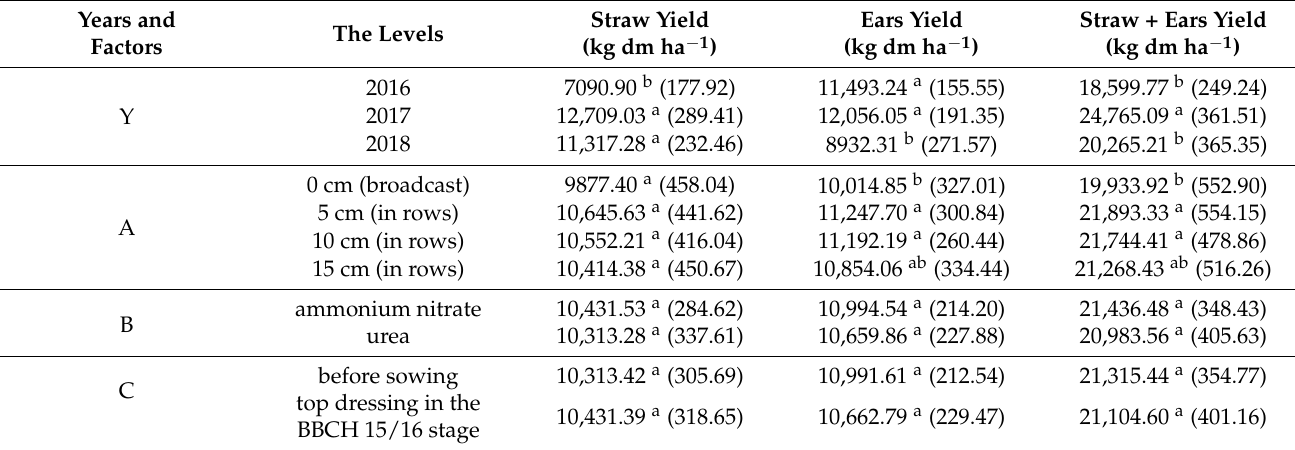
Table 6. Mean values of the traits for the years (Y) and NP fertilizer sowing depth (A), type of supplementary nitrogen fertilizer (B), date of supplementary nitrogen fertilization (C). Years